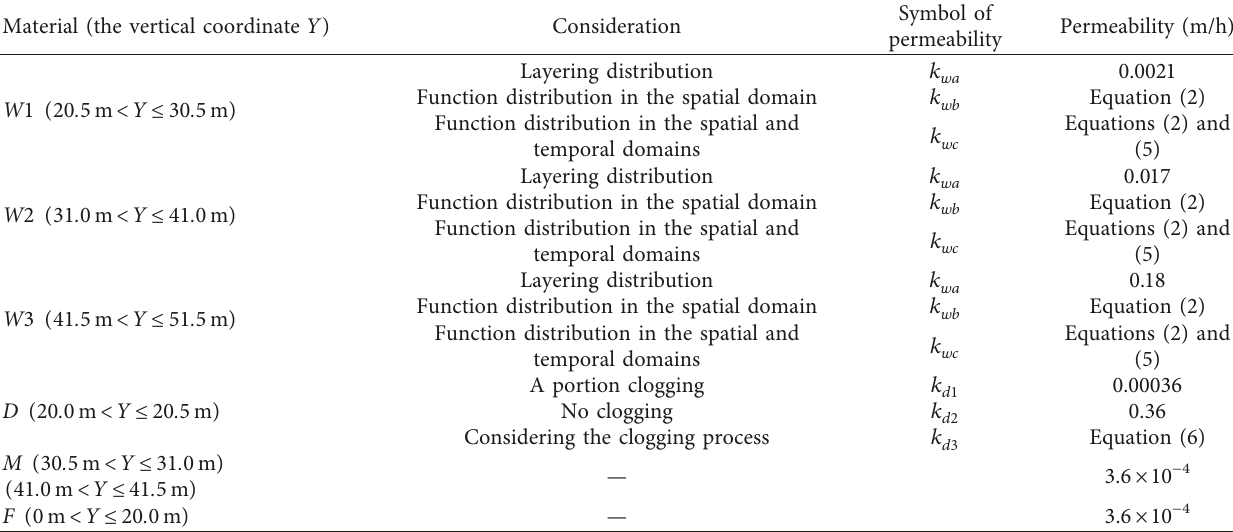
Table 1: Parameters of each part of the material.